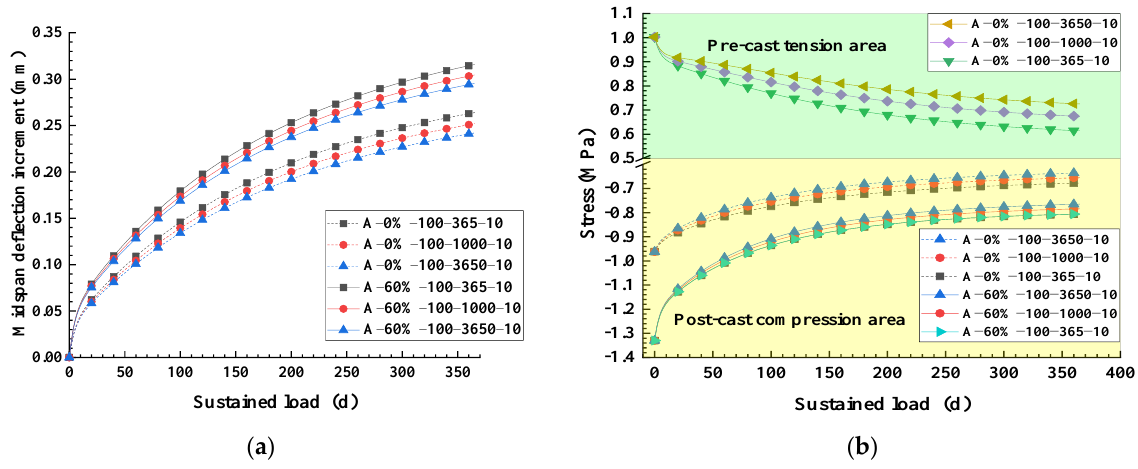
Figure 17. The creep effect of the fatigue- damaged concrete beams of different ages under loading: ( a ) the midspan deflection increment and ( b ) the section stress. ( a ) the midspan deflection increment and ( b ) the section